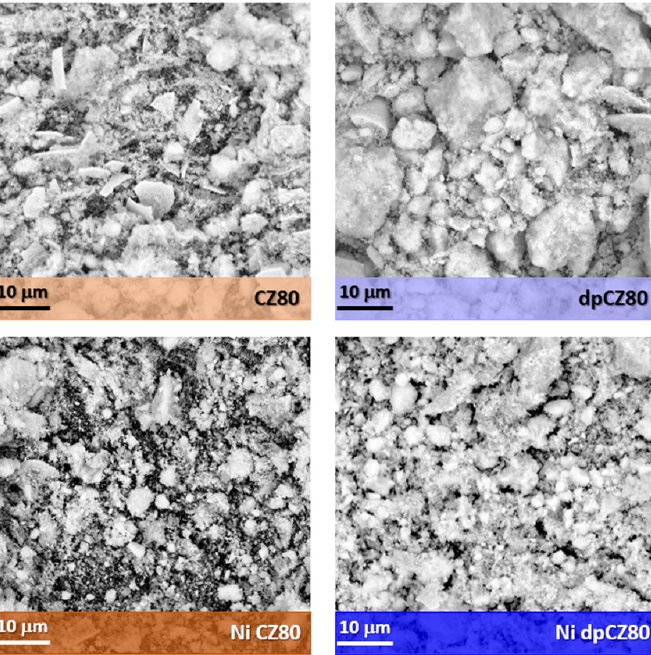
Figure 3. SEM micrographs of supports (undoped CZ80 and doped dpCZ80) and Ni supported catalysts, NiCZ80 and NidpCZ80.